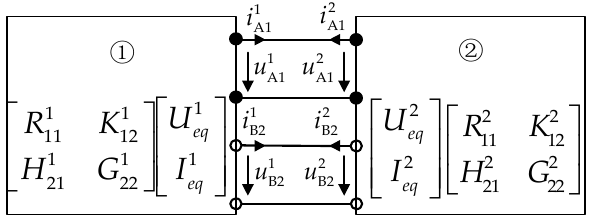
Figure 7. Two two-port hybrid equivalents connected to solve interface input currents/voltages.